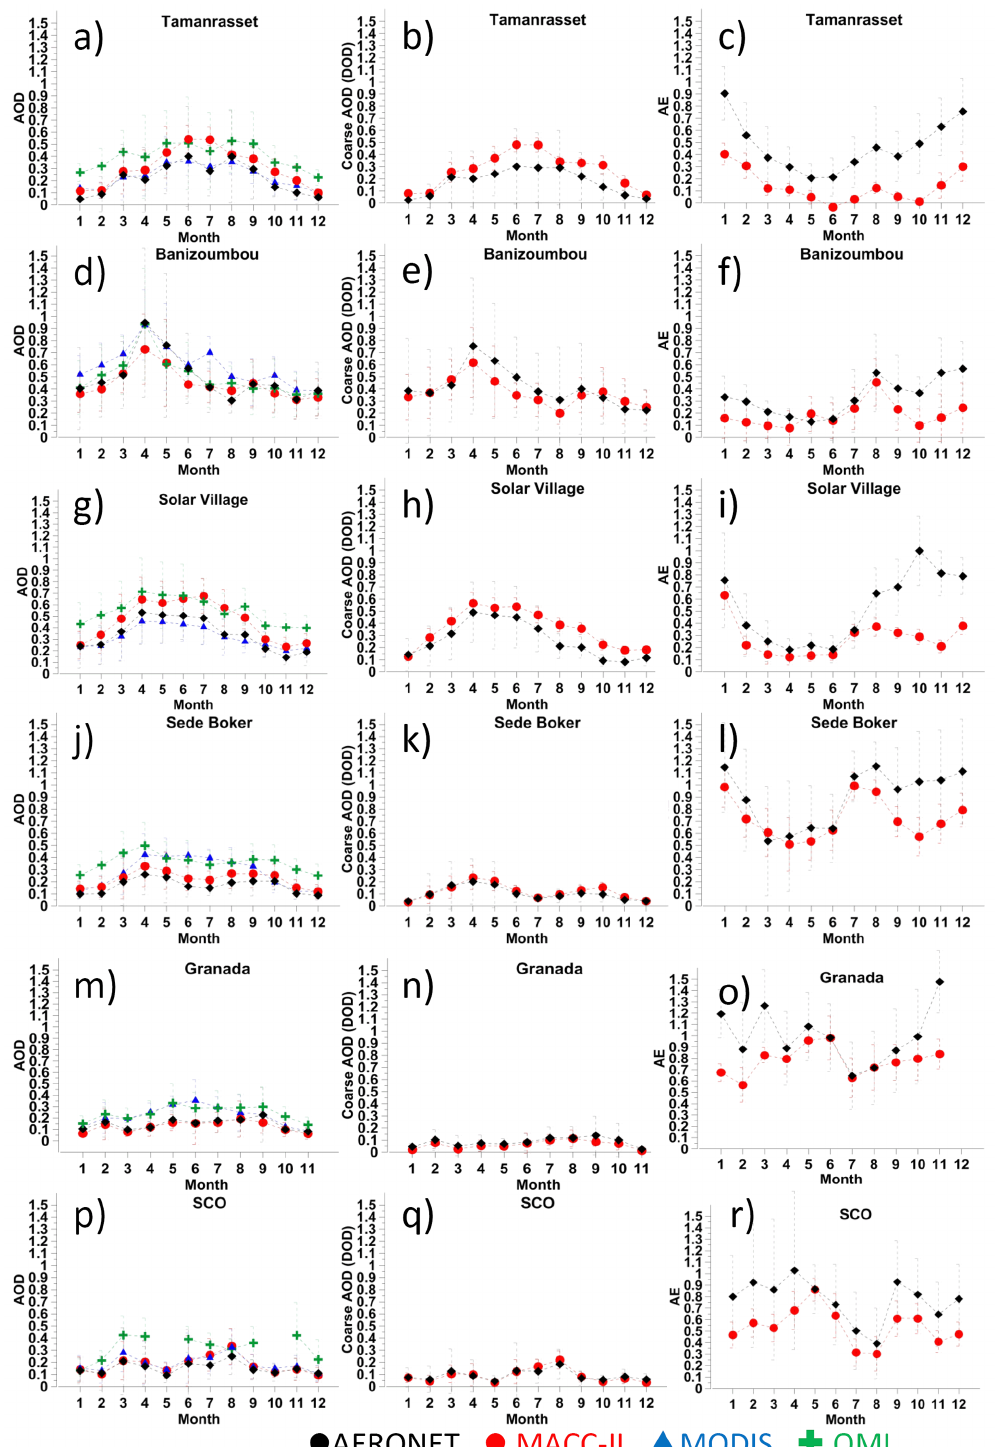
Figure 6. Monthly averages (2007–2008) of AOD from AERONET, MACC-II, MODIS-Aqua and OMI, AODcoarse (DOD) from AERONET and MACC-II, and AE from AERONET and MACC-II over Tamanrasset ( a , b and c ), Banizoumbou ( d , e , and f ), Solar Village ( g , h and i ), Sede Broker ( j , k and l ), Granada ( m , n and o ) and Santa Cruz de Tenerife (SCO) ( p , q and r ).